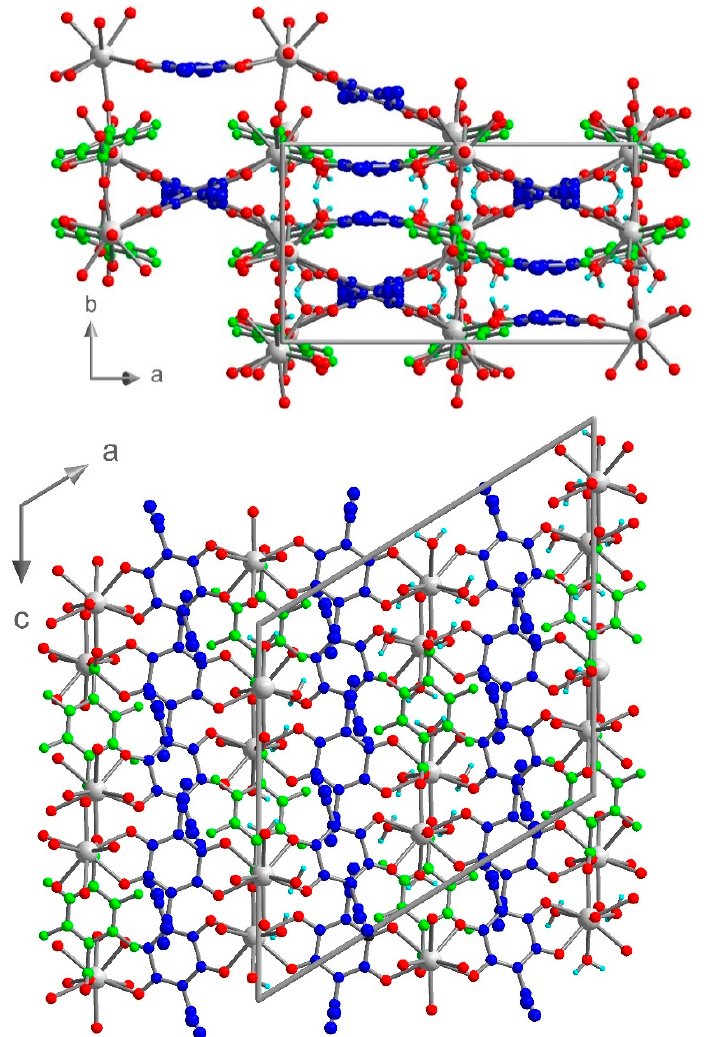
Figure 6. View of the crystal structure of 3 in the ab plane (top) and in the ac plane (bottom). ClCNAn 2 − and F 4 BDC 2 − are highlighted in blue and green respectively.